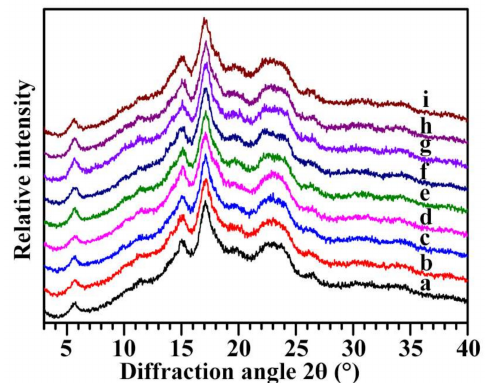
Figure 3. XRD patterns of starches from variety 3113 ( a ), Benlizi ( b ), Dahongpao ( c ), Erqingzao ( d ), Heishanzhai 7 ( e ), Mi 5 ( f ), Mi 6 ( g ), Yangguang ( h ), and Yanshanhong ( i